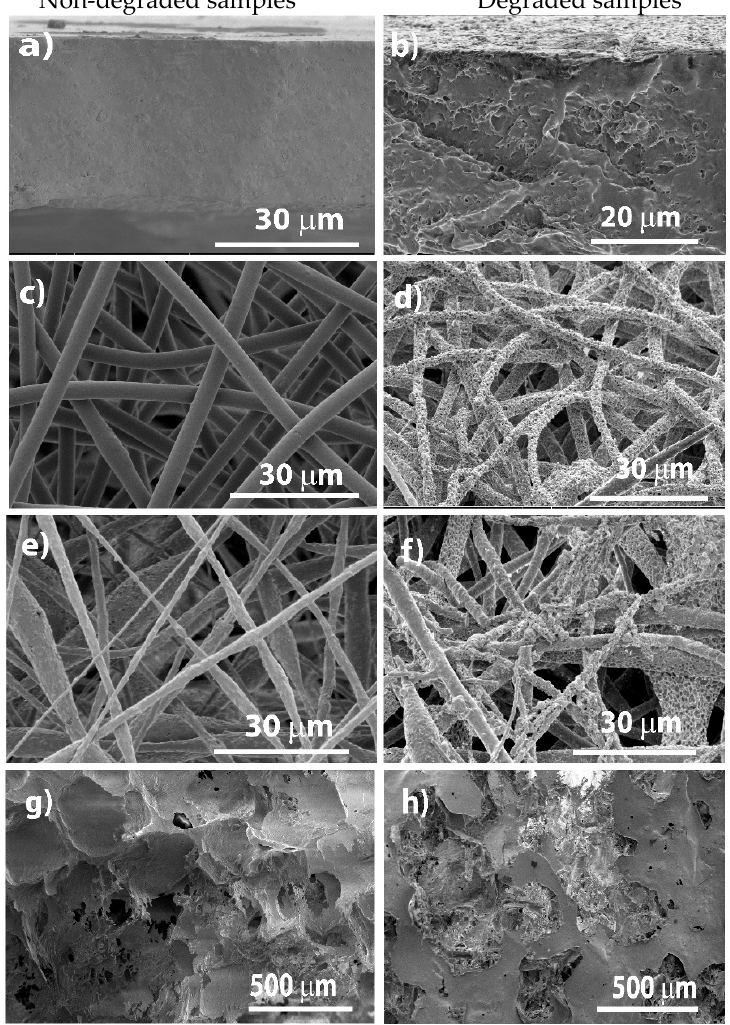
Figure 3. Cross-section SEM images of representative samples: PHBV/CFO films ( a , b ), PHBV fibers ( c , d ), PHBV/CFO fibers ( e , f ) and PHBV/CFO scaffolds ( g , h ), before and after degradation, respectively.